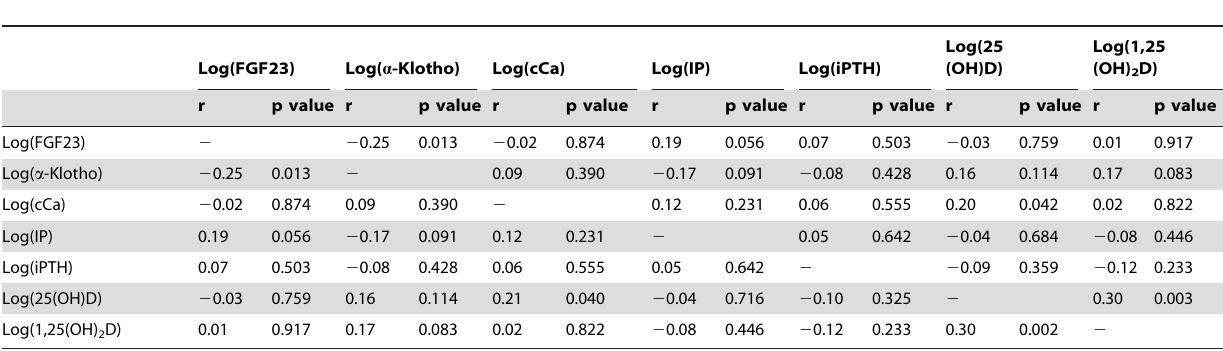
Table 5. Pearson’s correlation coefficients between variable related to calcium-phosphate